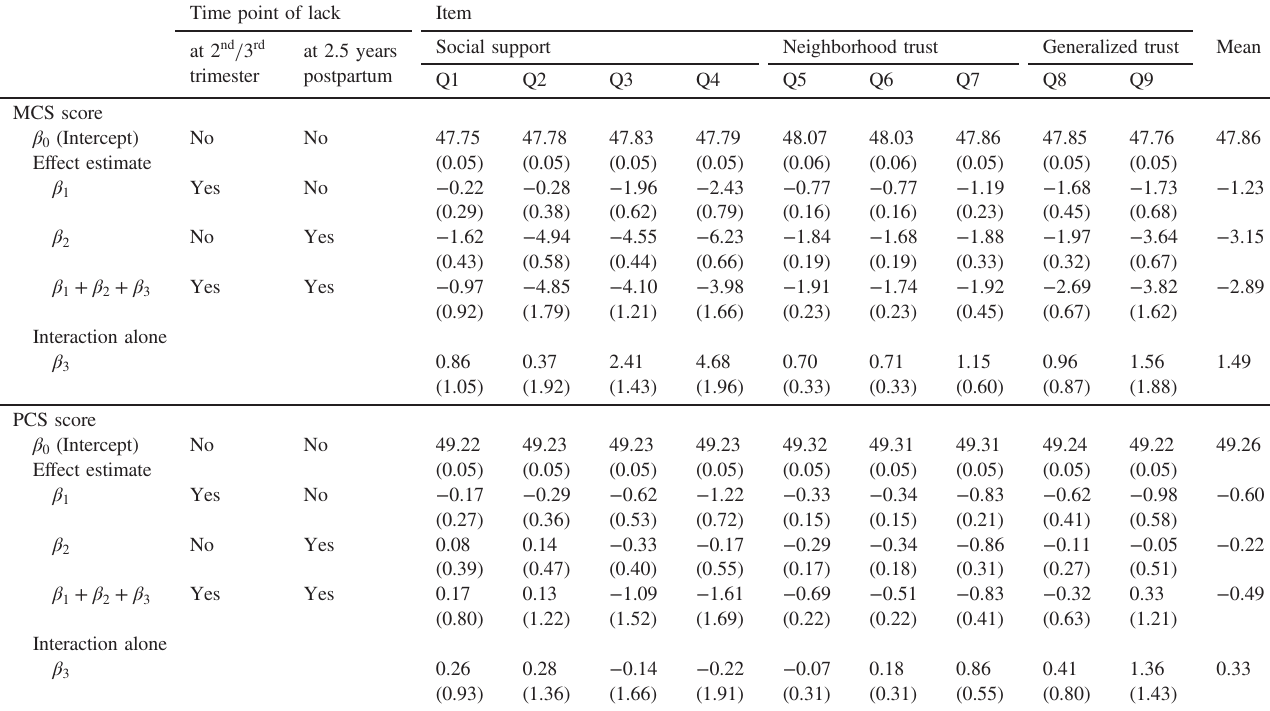
Table 3. E ff ect estimates for MCS and PCS scores according to the type of a lack of social support and trust Time point of lack Item Social support Neighborhood Meanat 2 nd / 3 rd at 2.5 years trimester postpartum